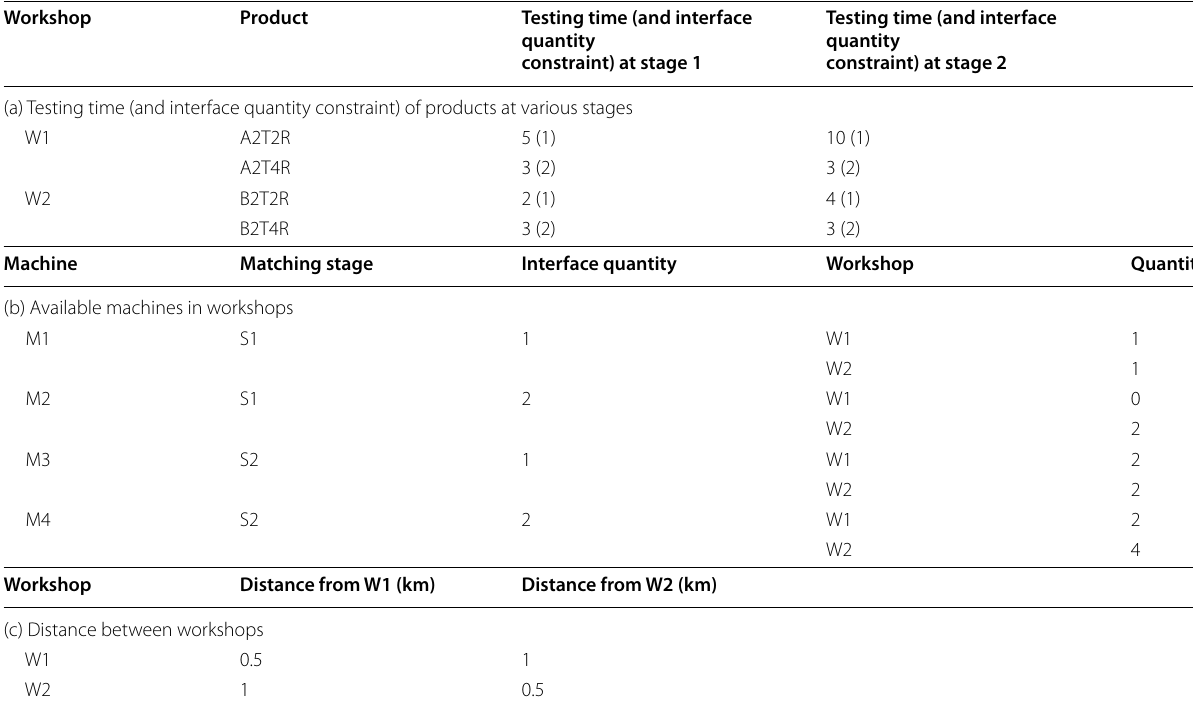
Table 2 Product and testing machine information Workshop